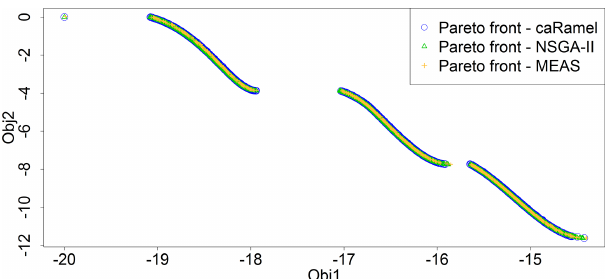
Figure 7. Pareto front after 50000 model evaluations with caRamel (1183 points), NSGA-II (1780 points) or MEAS (687 points) for the Kursawe test